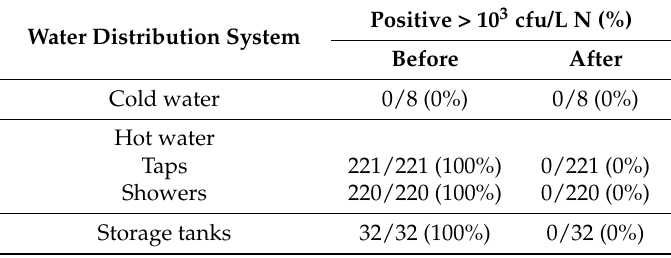
Table 2. Legionella pneumophila sg5 contamination of the drinking and hot water distribution systems (WDS) before and after the start of continuous disinfection with monochloramine (2–3 mg/L). Positive > 10 3 cfu/L N (%) Water Distribution System Before After Cold water Hot water Taps 0/32 (0%)